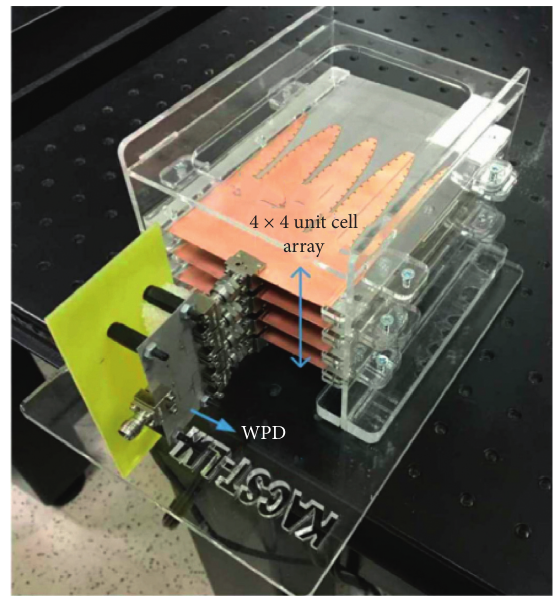
Figure 13: Box for placement of the four 1 × 4 antenna arrays as shown in